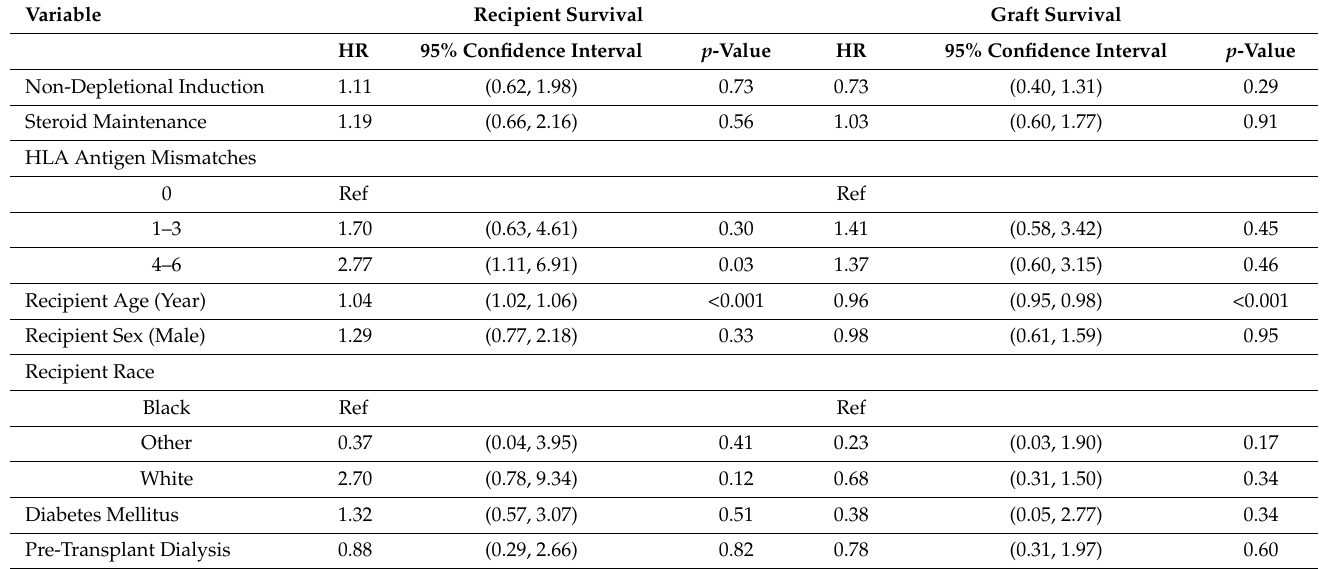
Table 4. Multivariable Cox Proportional Hazards Models for Recipient Survival and Death-Censored Graft Survival in anti-GBM Glomerulonephritis.